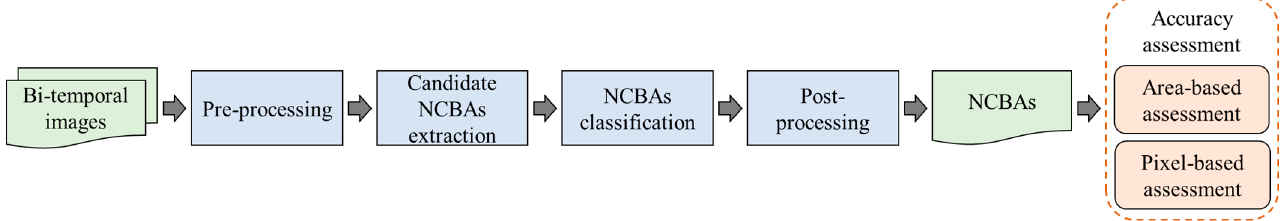
Figure 1. The workflow of the refined change detection method for newly constructed building areas (NCBAs).